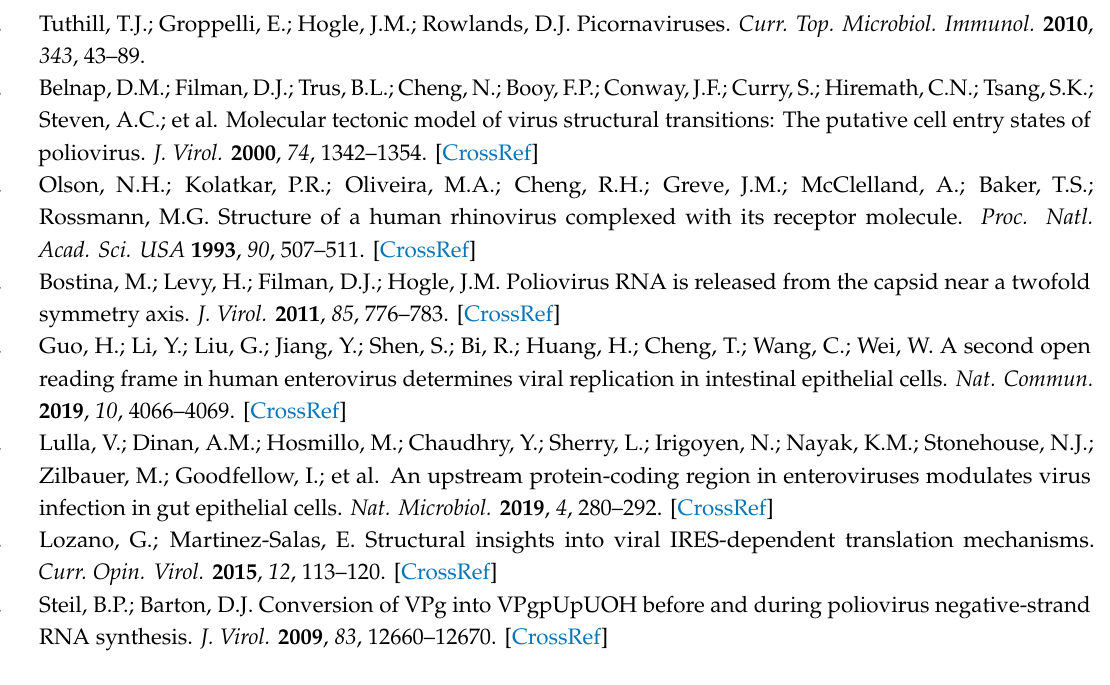
Figure S1: Mutations on 2A, 2B and 2C non-structural proteins in all CVB1 PIDVs established in TP2. The location and the corresponding amino acid substitution are shown in the top line and the corresponding PIDVs are presented below. I50V in 2B, marked with grey color, is in hydrophobic domain of and K58R in hydrophilic domain. M175L, marked with grey color in 2C is in ATPase motif B region, Table S1. The 50% endpoint titers for CVB1 ATCC and CVB1 10796 viruses in PANC-1 cell model (in TCID 50 / mL) measured by TCID 50 assay for 6.8 months post infection, Table S2. Human alignment is processed from Vipie virome pipeline [1] based on de novo Velvet [2] contig mapping using minimum Kmer 51 (data is available upon request). The mean CVB / Human Proportions of all samples are 13.01% (PANC-1 6.68% and 1.1B4